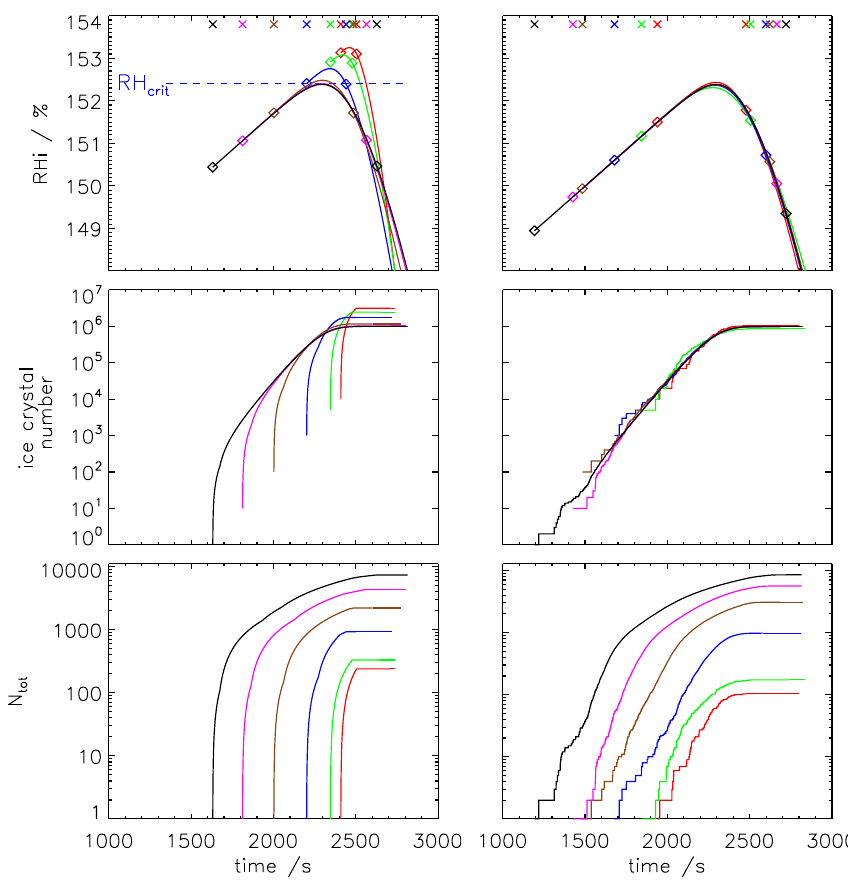
Fig. 9. LCM box model simulations without (left) and with (right) stochastic nucleation implementation. Temporal evolution of relative humidity, ice crystal number N and SIP number N tot . The setup is similar to the slow updraught simulation with w syn = 2cm / s and ∆ t NUC = 0 . 4s . Simulations for various minimal ice crystal numbers in a SIP ν min = n min V GB are depicted: 10000 (red), 5000 (green), 1000 (blue), 100 (brown), 10 (magenta) and 1 (black). The crosses indicate the times the first and the last SIP are created. The plotting of relative humidity curve starts when the first SIP is created.